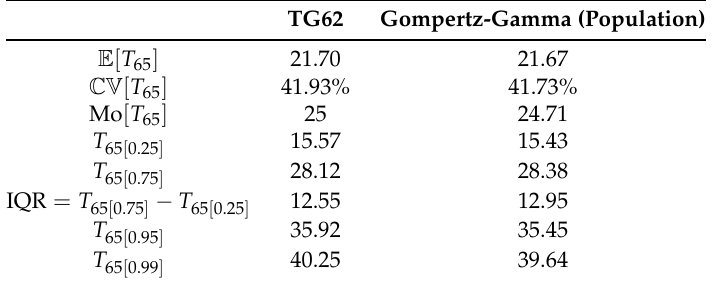
Table 2. Summary statistics of the probability distribution of the lifetime T 65 . General population.